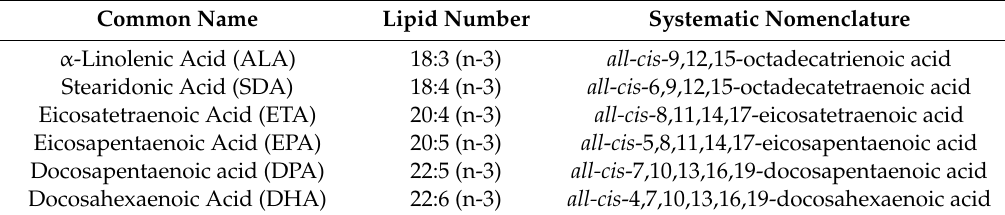
Table 1. Main n-3 LCPUFAs.